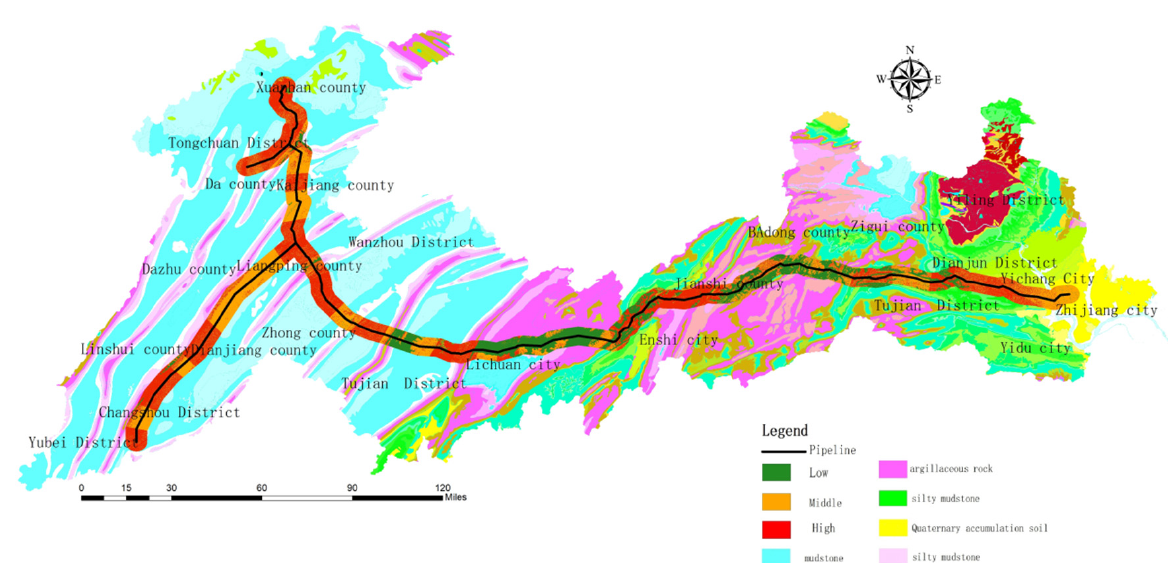
Figure 16. Hazard partition of the WOE-GA-BP model.